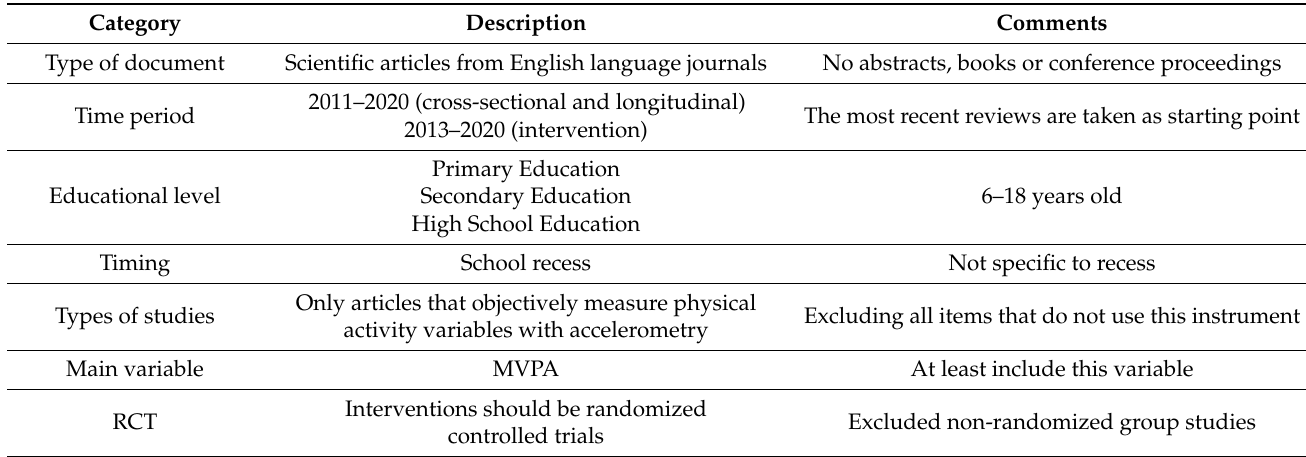
Table 2. Inclusion/exclusion